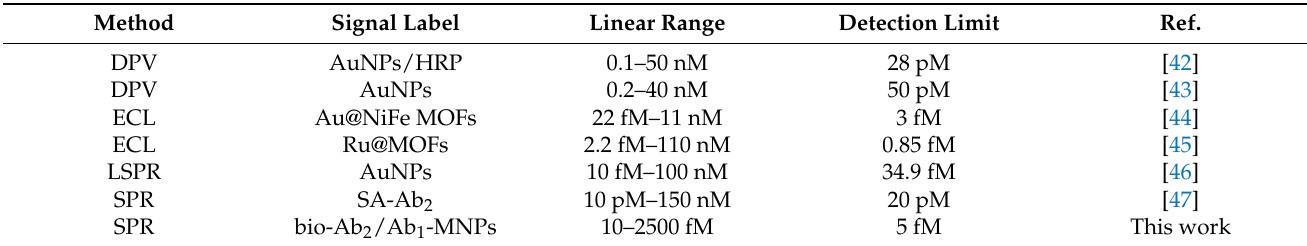
Figure 4. ( A ) SPR sensorgrams for the detection of different concentrations of A β 40 (a–g: 10, 100, 250, 1000, 2000, 2500 and 5000 fM). ( B ) Dependence of SPR signal on A β 40 concentration. The inset shows the linear portion of the fitting curve. Table 1. An overview of different sandwich biosensors for A β 40